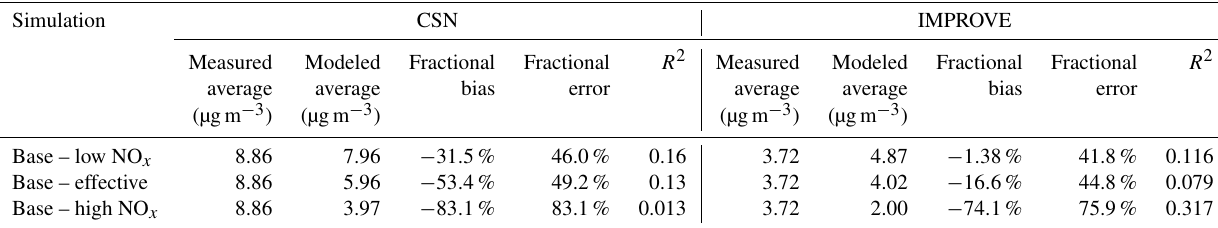
Table 4. Statistical metrics of averages, fractional bias, fractional error, and R 2 for the model–measurement comparison in southern Califor- nia. Simulation CSN IMPROVE Measured Modeled Fractional Fractional R 2 Measured Modeled Fractional Fractional R 2 average average bias error average